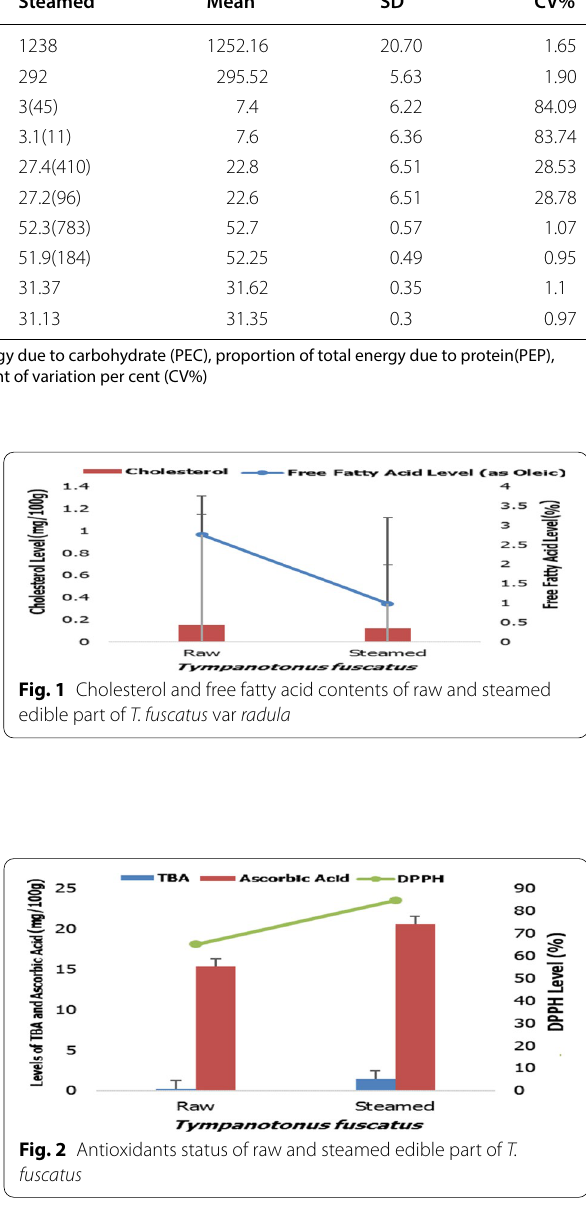
Table 5 Energy value contributed by nutrients in raw and steamed African Mud Creeper, T. fuscatus var radula Parameter